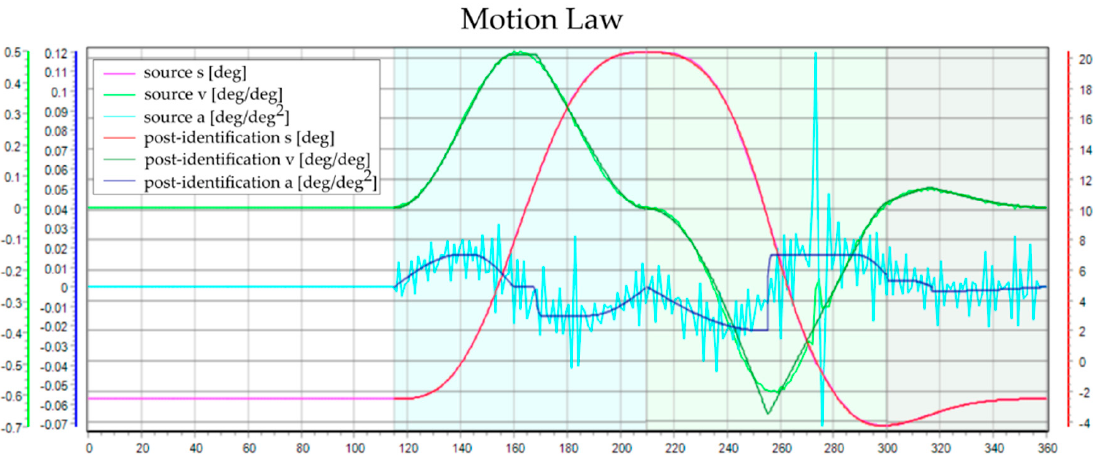
Figure 11. Comparison between the experimental law of motion (light blue) and modified trapezoidal laws for each phase (with equal coefficients values) after identification based on displacement by adopting EN.